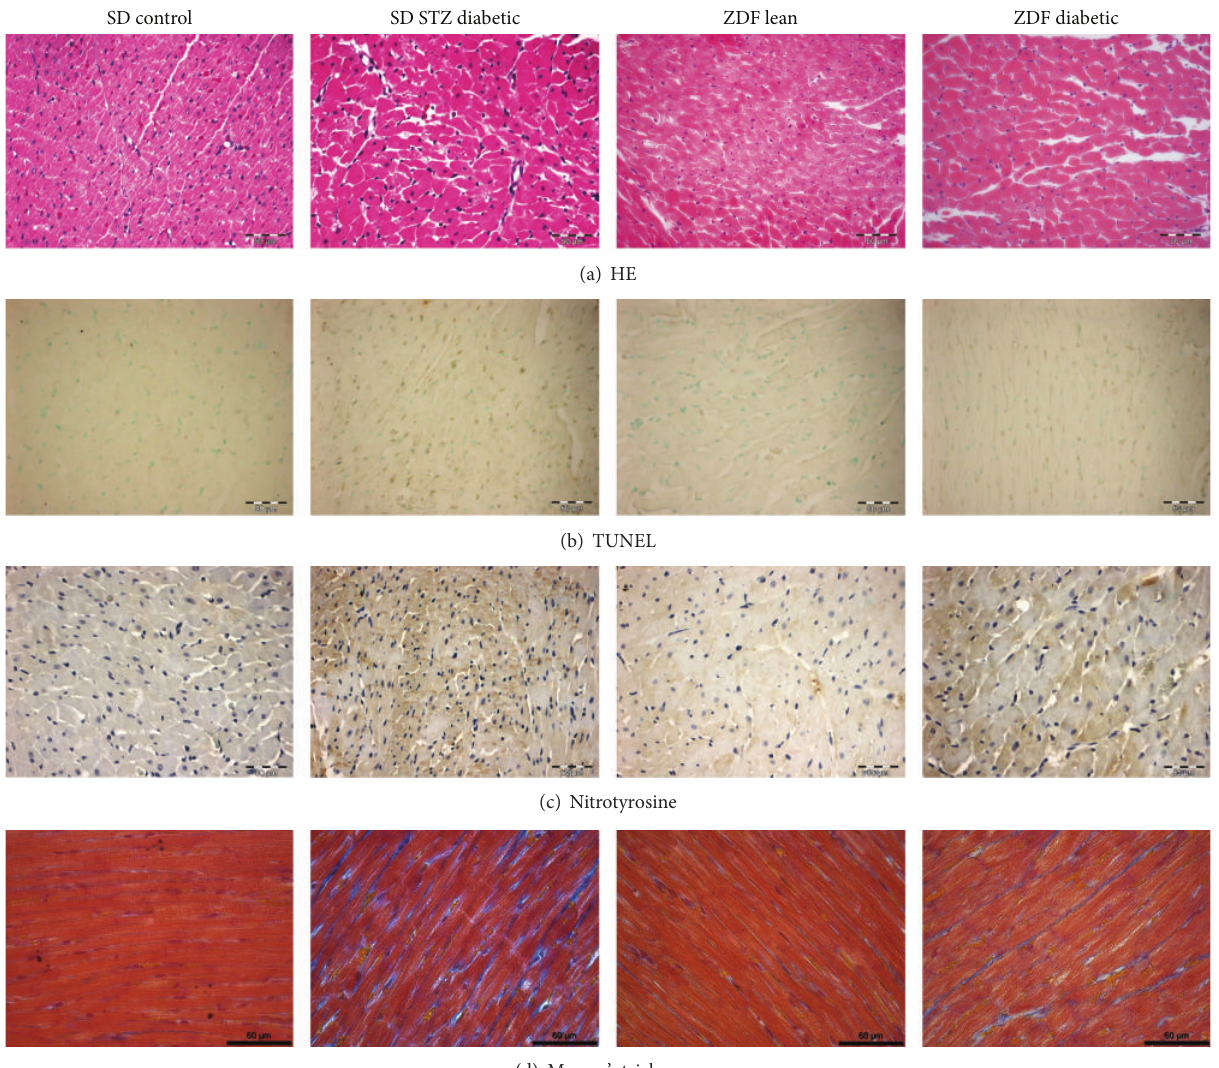
Figure 2: Characteristic histopathological changes of the myocardium in type-1 and type-2 diabetes mellitus (DM) models. Representative images of conventional histopathological examination (hematoxylin-eosin (HE) staining; scale bar: 50 𝜇 m, (a)), TUNEL staining for DNA breaks and apoptosis (brown cell nuclei, scale bar: 50 𝜇 m, (b)), immunohistochemistry for the nitrooxidative stress marker nitrotyrosine (brown staining, scale bar: 50 𝜇 m, (c)) and Masson’s trichrome staining for fibrosis detection (blue staining, scale bar: 60 𝜇 m, (d)) of left ventricular myocardium in the groups of SD control, streptozotocin- (STZ-) induced diabetic SD, ZDF lean and ZDF diabetic